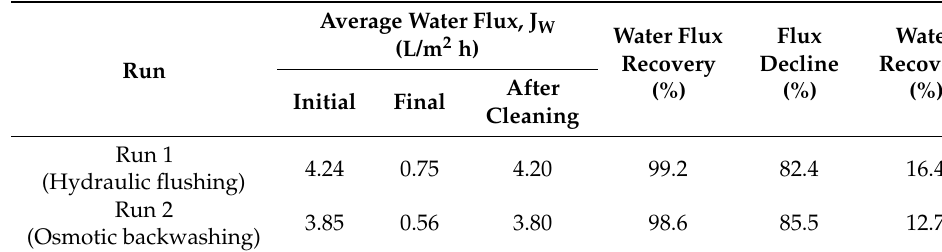
Figure 13. Field Emission Scanning Electron Microscopy (FESEM) images with 1000 × magnification on the active layer of the cellulose triacetate (CTA) membrane: ( a ) pristine membrane and ( b ) fouled membrane. Table 8. Results for fouling and cleaning experimental runs.